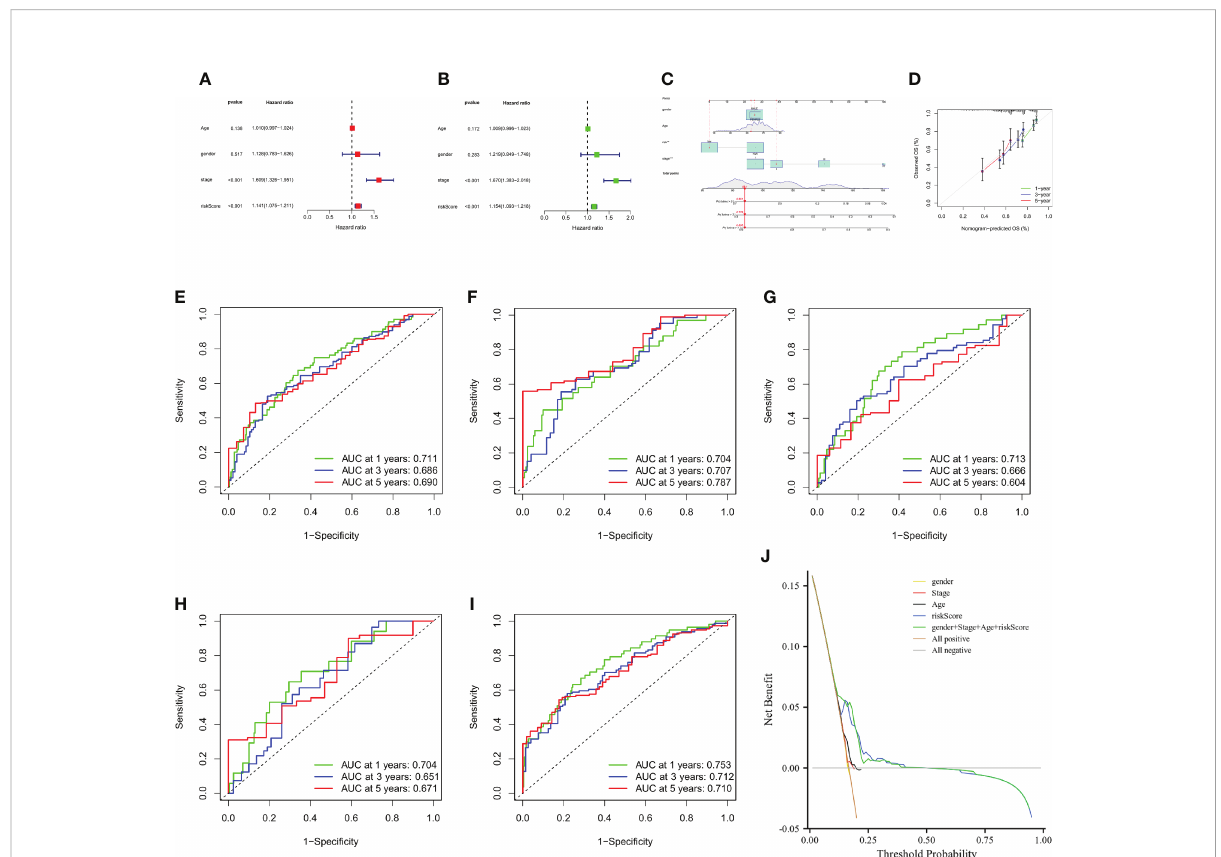
FIGURE 7 Construction and validation of a nomogram. (A, B) CMPRG_score and clinical characteristics of HCC were analyzed by univariate analysis and multivariate analysis. (C) Nomogram for predicting the 1-, 3-, and 5-year OS of HCC patients in the all sample. (D) Calibration curves of the nomogram for predicting of 1-, 3-, and 5-year OS in the TCGA and GSE76427 cohorts. (E – G) ROC curves for predicting the 1-, 3-, and 5-year ROC curves in the all sample, training, and testing sets. (H, I) ROC curves for predicting the 1-, 3-, and 5-year ROC curves in the GSE14520 (n = 221) and GSE116174 (n=64) cohorts. (J) Decision-making